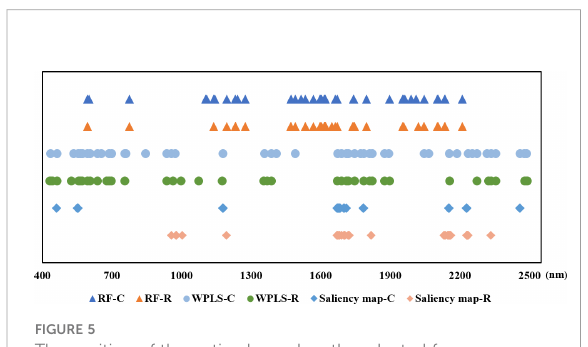
FIGURE 5 The position of the optimal wavelengths selected for